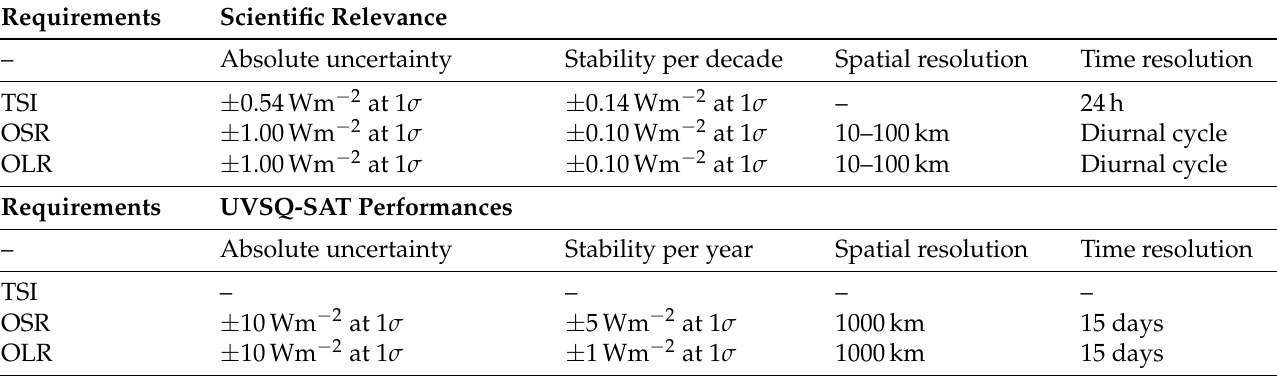
Table 2. Scientific requirements for the components of the Earth’s radiation budget. High scientific relevance for a satellites constellation (Terra-F) and UVSQ-SAT expected